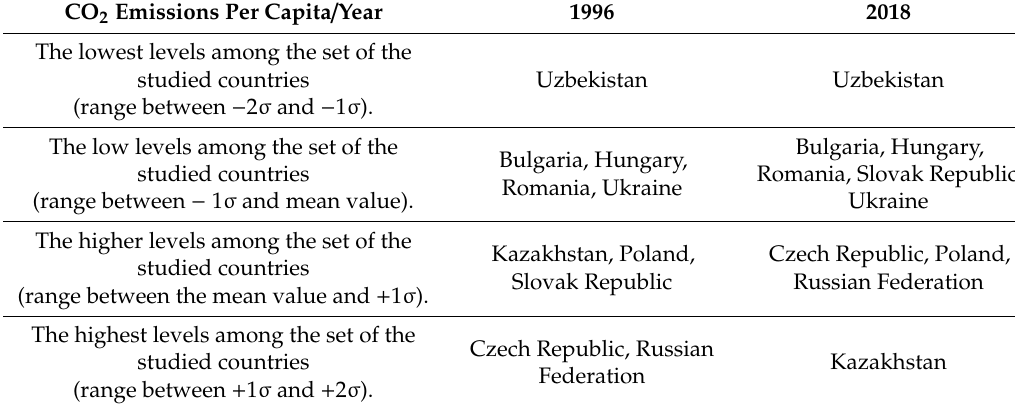
Table 1. The distribution of the studied countries according to levels of per capita CO 2 emissions in 1996 and